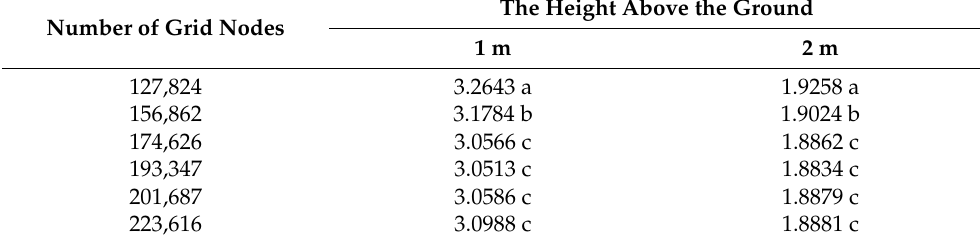
Table 1. Mesh-independent verification. Number of Grid Nodes